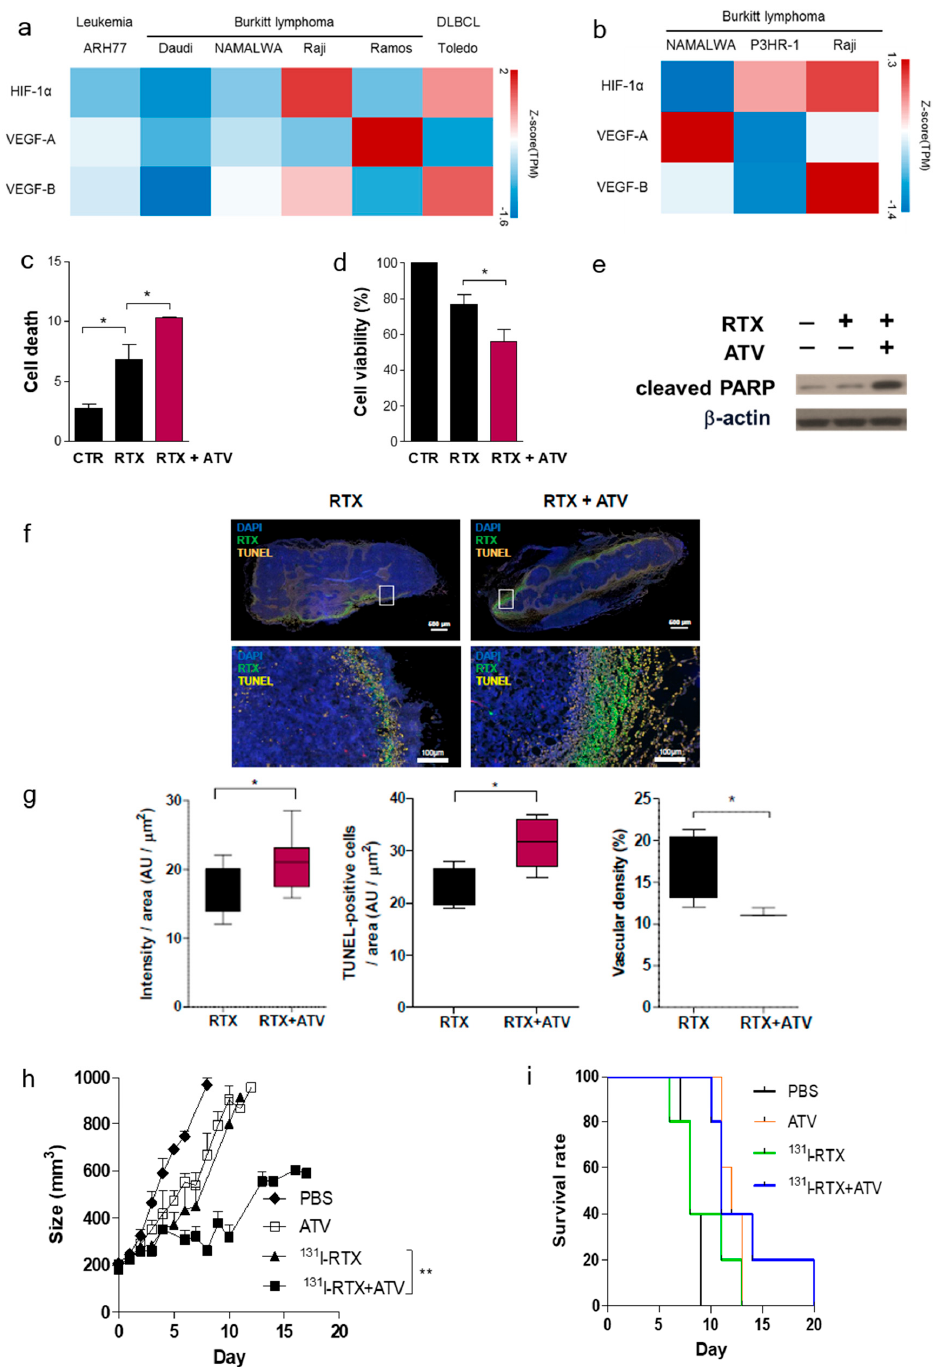
Figure 1. Atorvastatin (ATV) improved therapeutic effect of 131 I-RTX in Raji cells. ( a ) Public RNAseq database, Expression ATLAS (EMBL-EBI, http://www.ebi.ac.uk/gxa). Expression ATLAS provided several immortalized B cell lines Project 6 of Open Targets—Epigenomes of Cell Lines. ( b ) RNAseq of 934 human cancer cell lines from the Cancer Cell Line Encyclopedia. ( c , d ) The apoptosis rate and cell viability were assessed by FACS analysis and trypan blue assay after atorvastatin (ATV) or ATV + rituximab (RTX) treatment. ( e ) Apoptosis was confirmed by western blotting of cleaved PARP. Raji